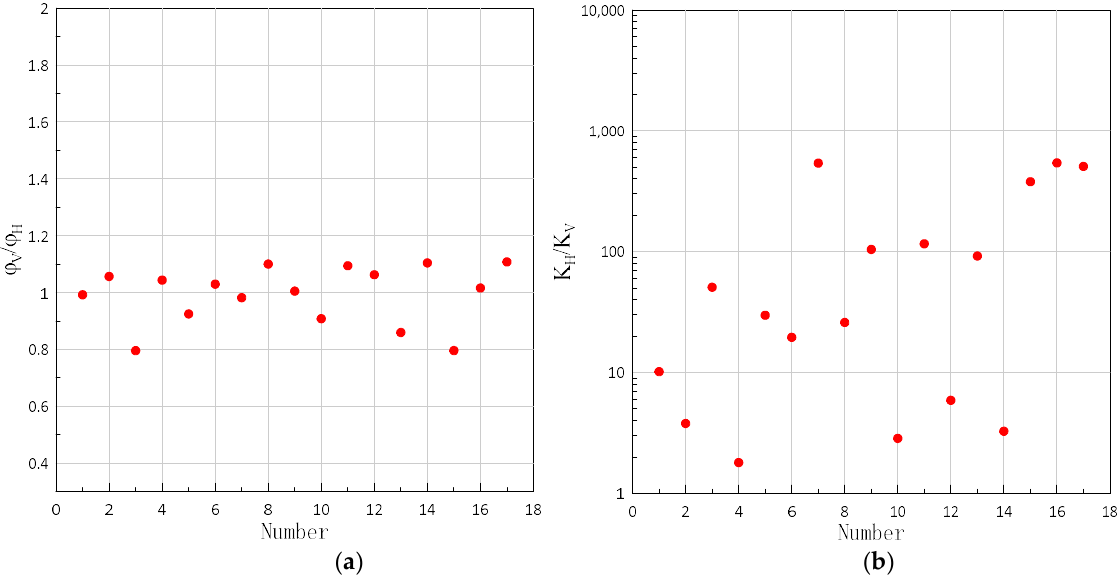
Figure 11. The heterogeneity of porosity and permeability. ( a ) Porosity; ( b ) permeability.